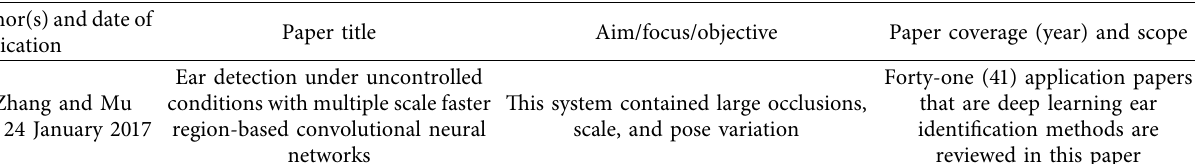
Table 8: Cont. differences between this review article and the recent/existing review papers.